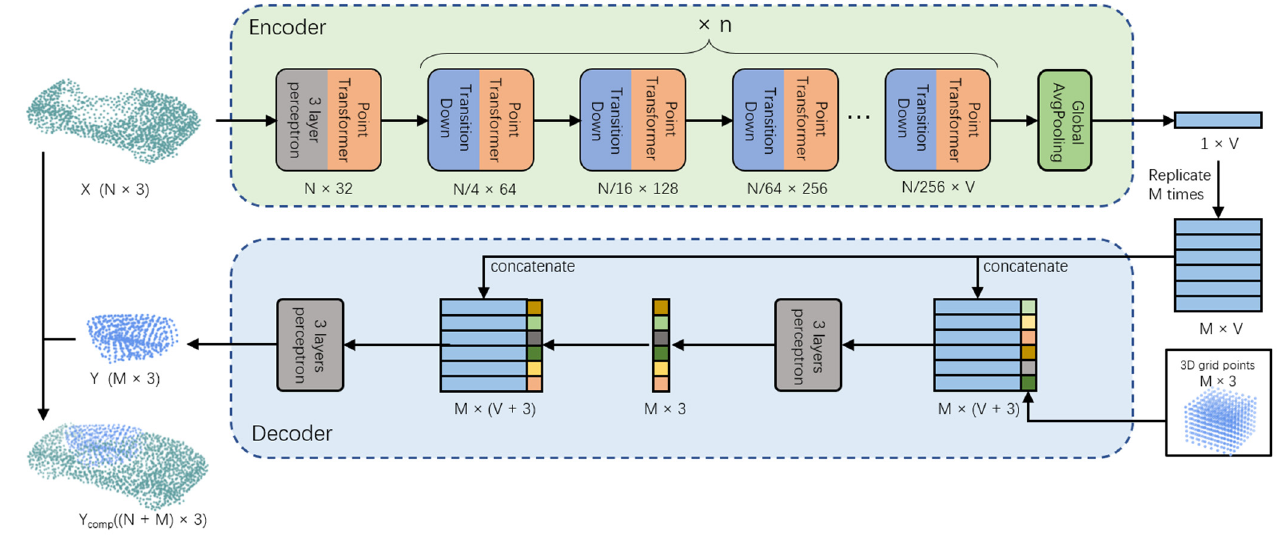
Figure 1. Network architecture mainly consists of a transformer-based encoder and an improved fold-based decoder.